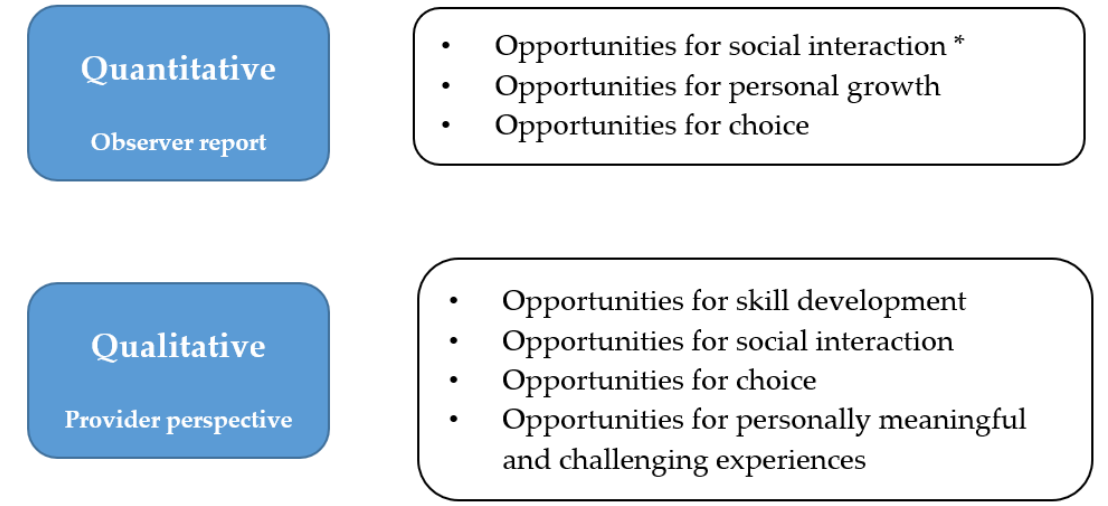
Figure 1. Evidence for RILS Program Opportunities. * A combination of three MEQAS scales: opportu- nities to interact with adults, with peers, and for cooperative group activity. This figure refers to findings from several articles. [33,37].